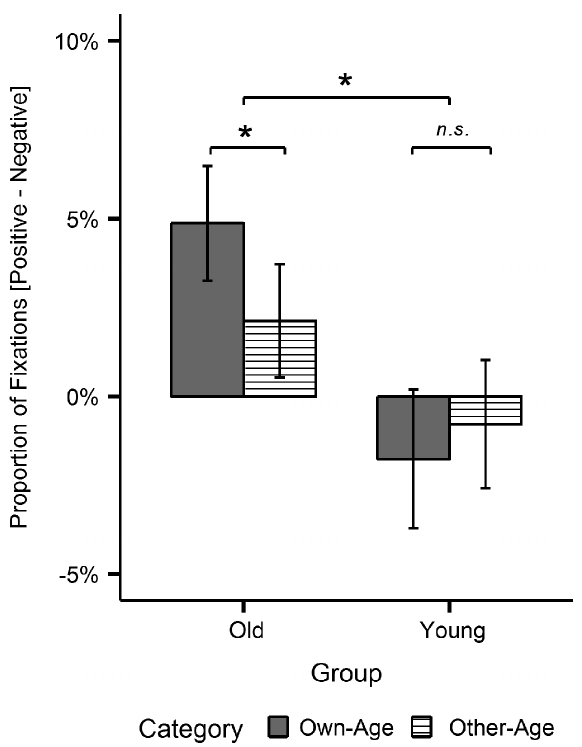
Figure 5. Post-hoc test results for interactions with image category. Difference between proportions of fixations for positive minus negative images in the two image categories (own-age vs. other- age), plotted separately for each age-group. Error bars represent standard errors of the mean. * p , .05, n.s. =not significant.